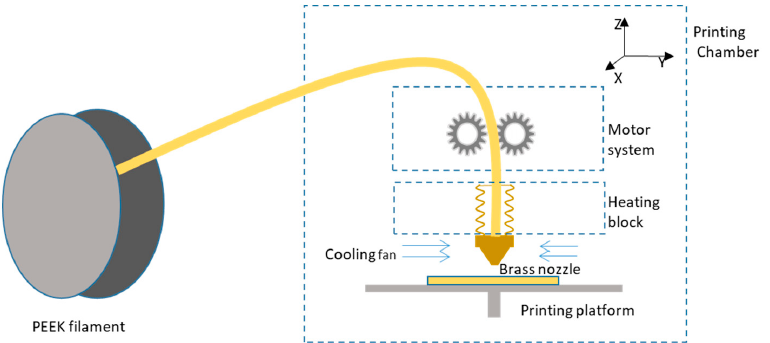
Figure 1. Schematic diagram of fused deposition modeling (FDM) 3D polyether ether ketone (PEEK) printer.